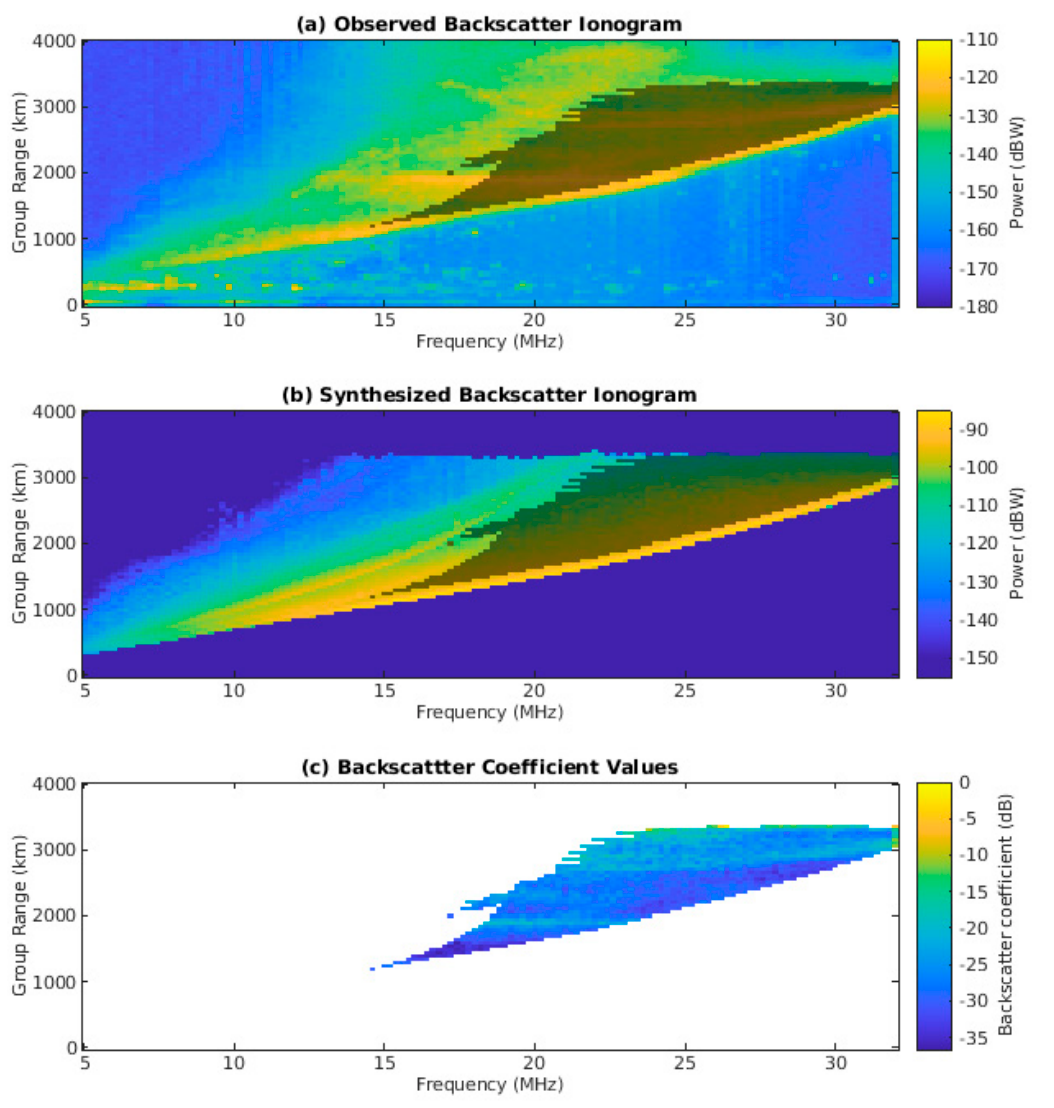
Figure 2. Observed ( a ) and modelled ( b ) backscatter ionograms with the area deemed suitable for calculating backscatter coefficients shadowed. Backscatter coefficient values ( c ) are obtained by taking the difference in power between the modelled and observed ionograms.